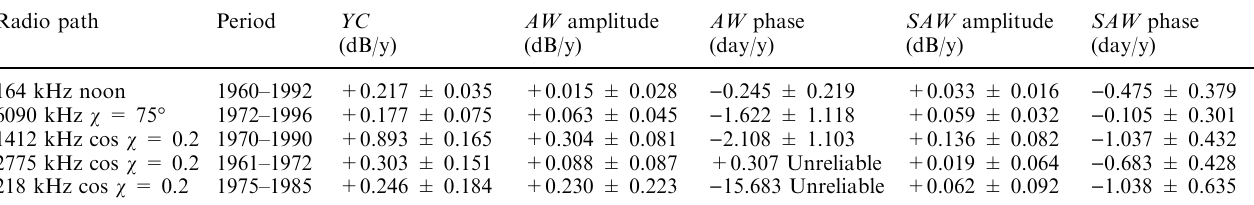
Table 2. Cross-correlation coe(cid:129)cients of yearly values, YC-AW and YC-SAW , for all five radio paths. Maximum co- rrelation with corresponding time lag (years; + means the YC leads), and correlation with no time lag (correlation lag 0) are